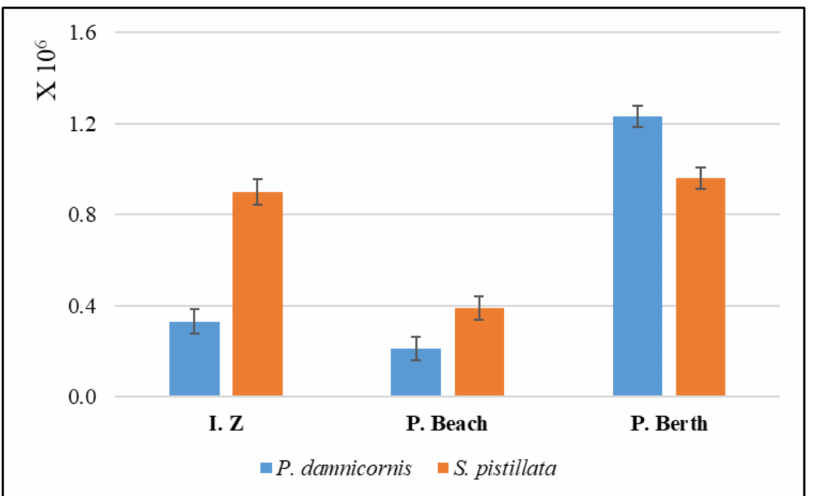
Figure 3. Viable bacterial counts of seawater surrounding P. damicornis and S. pistillata expressed in colony-forming units per mL (CFU/mL). (I.Z: Industrial Zones, P. Beach: Public Beach, P. Berth: Phosphate